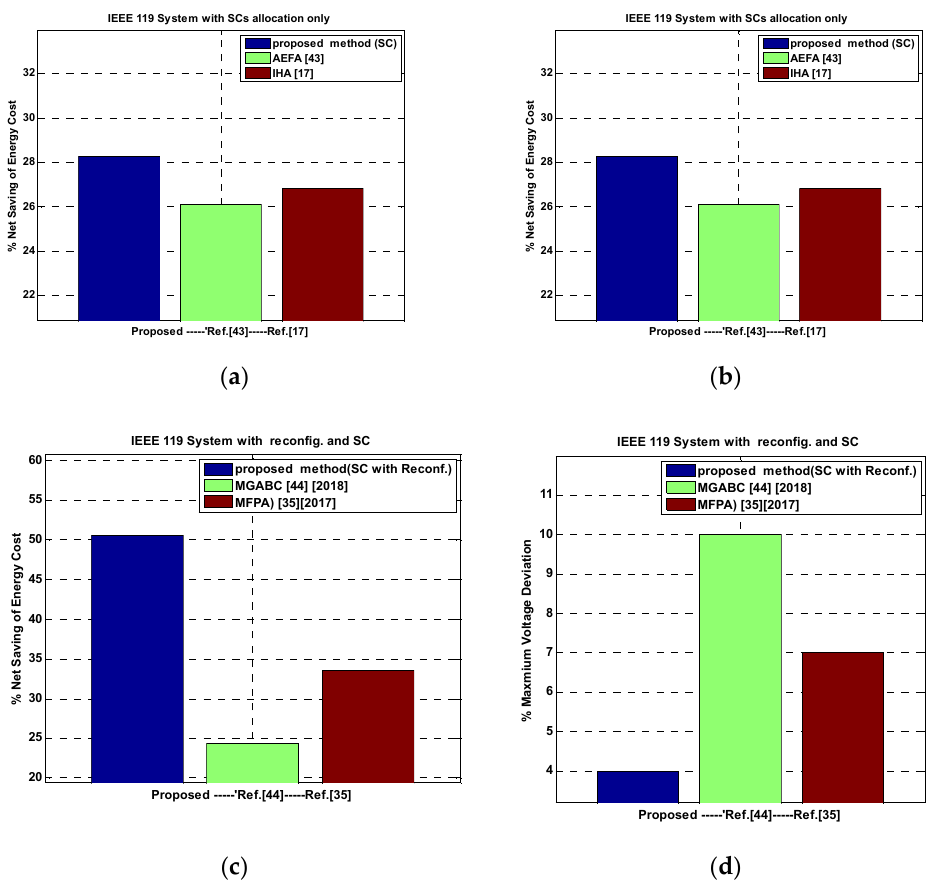
Figure 5. Comparison of the IEEE 119 system between the proposed algorithm and the best previous algorithms: ( a ) Energy-saving % with reconfiguration only; ( b ) energy-saving % with shunt capacitor allocation only; ( c ) energy-saving % with shunt capacitor allocation and reconfiguration; ( d ) maximum voltage deviation %. Table 7. IEEE 119 system with reconfiguration only.